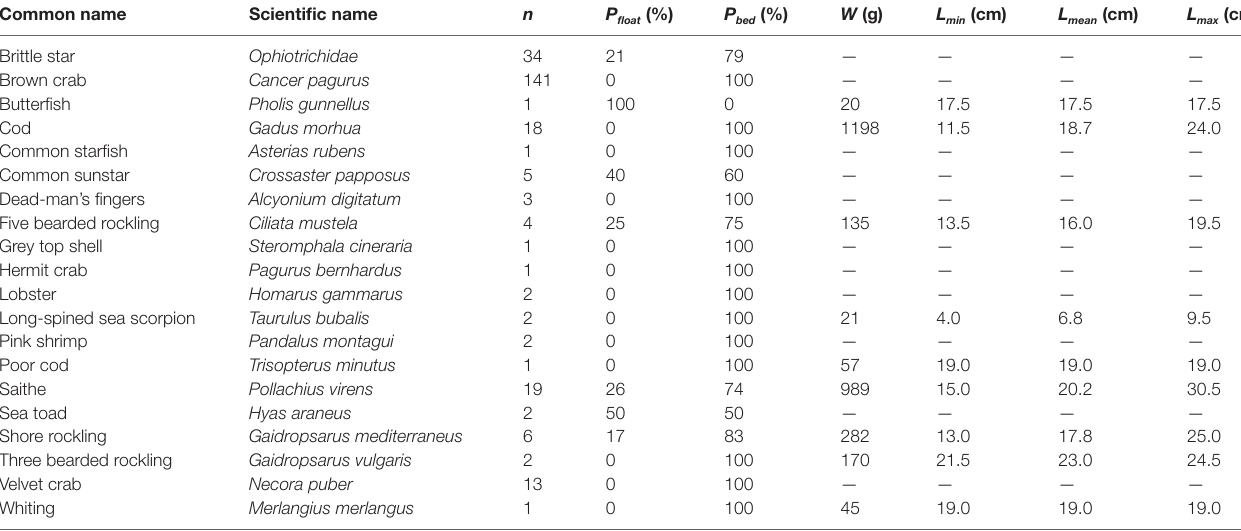
TABLE 1 | Overall fish traps catches across Bluemull Sound (32 traps deployed), Yell Sound (12 traps deployed), and the Sound of Papa (20 traps deployed). Common